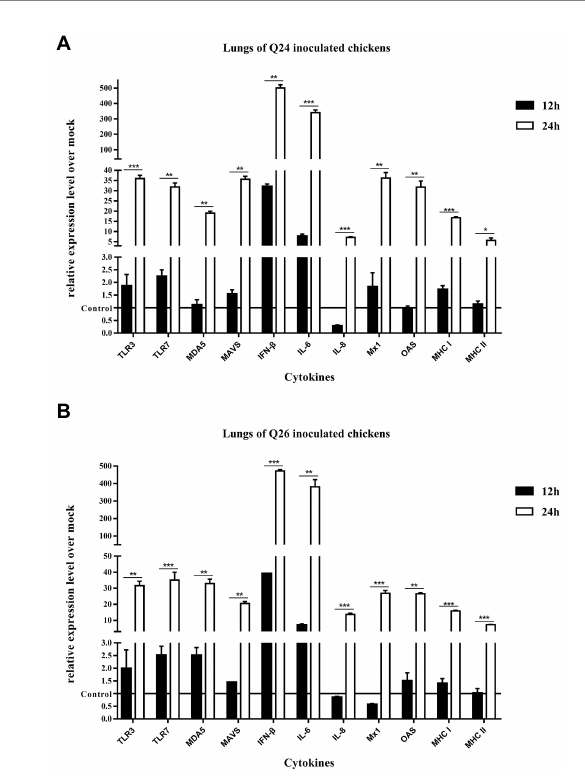
FIGURE 10 The expressions of immune-relate genes in the lungs of inoculated chickens. Comparing of the expressions of TLR3, TLR7, MDA5, MAVS, IFN- β , IL-6, IL-8, Mx1, OAS, MHC I, and MHC II in the lungs harvested from the inoculated chickens by (A) Q24 and (B) Q26 H7N9 AIVs at 12 and 24 HPI, respectively. They were tested using the quantitative RT- PCR and calculated as follows: fold change = 2 - △△ Ct , which △ = Ct target-Ct β -action, and △△ Ct = △ Ct treated- △ Ct control. Therefore, the expressions of all of the cytokines in the health control chickens were 1. We carried out the Student’s t -test between the experimental groups at 12 and 24 HPI, p < 0.05 was identified statistically significant (* p < 0.05; ** p < 0.01; *** p < 0.001).